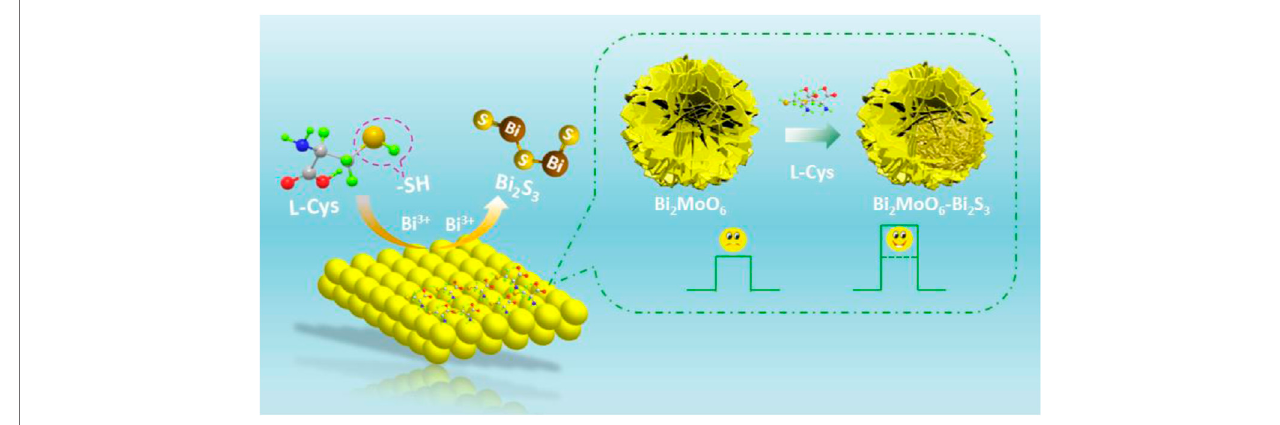
SCHEME 1 | Illustration of the proposed PEC sensor.